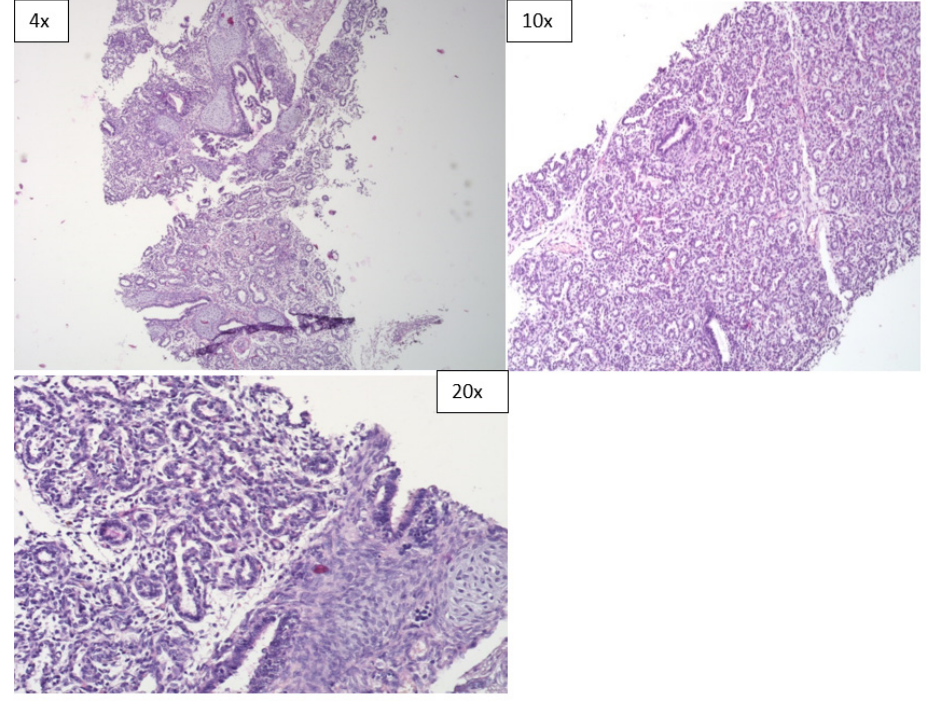
Figure 2. Microscopic sections of lung tissues obtained during the MITS procedure (H & E).